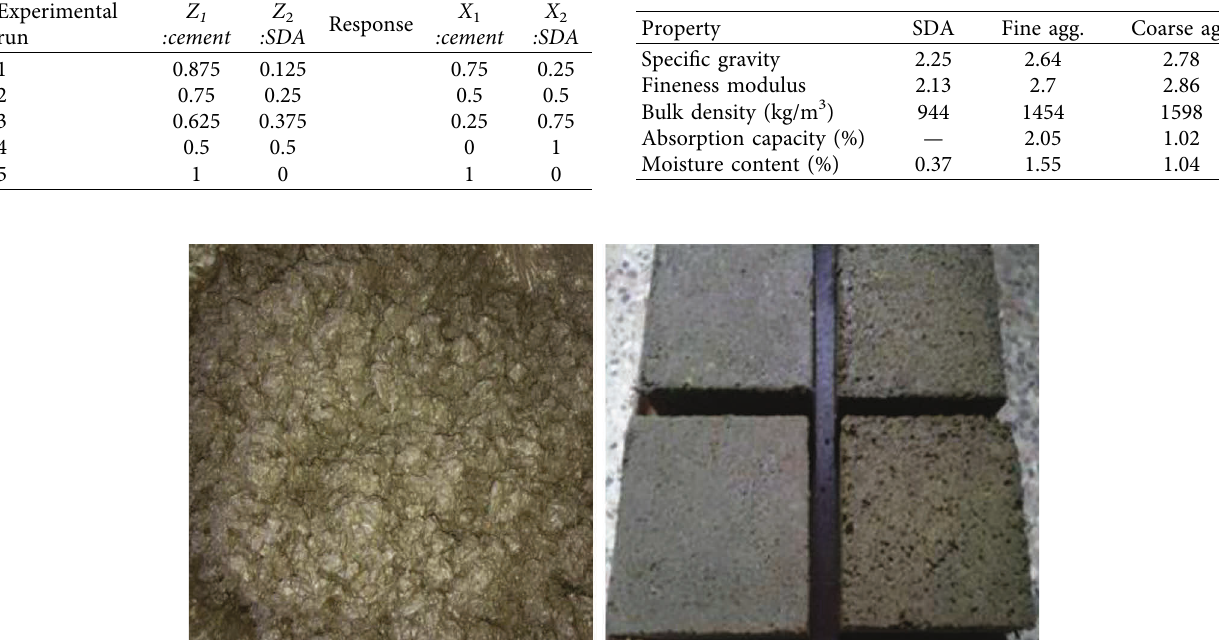
Figure 4: Two-component standard error design plot. Table 4: Component proportion mixes for the experimental study. Table 6: Physical